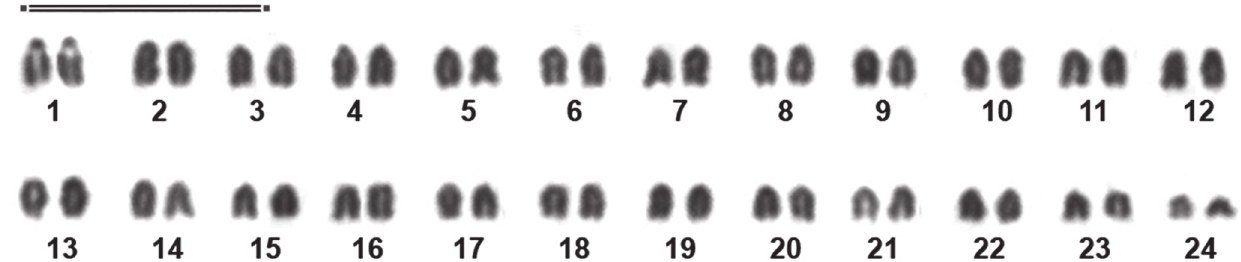
Fig. 1. Giemsa-stained karotype of Mugil incilis . Scale bar = 10